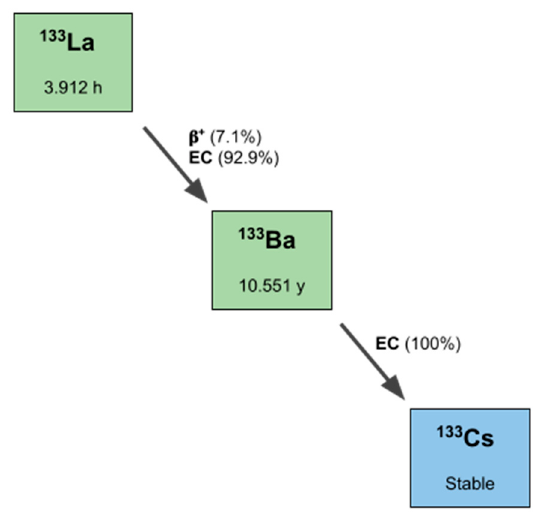
Figure 6. Decay scheme of 133 La, including the half-life and type of decay.